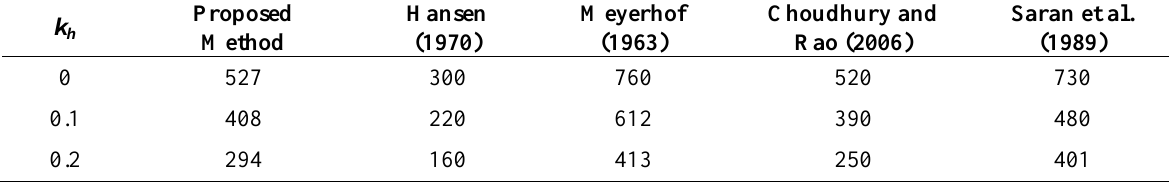
Table 2. Comparison of the proposed method to determine seismic bearing capacity of the footing on unreinforced slope with other methods (values in kPa) k h